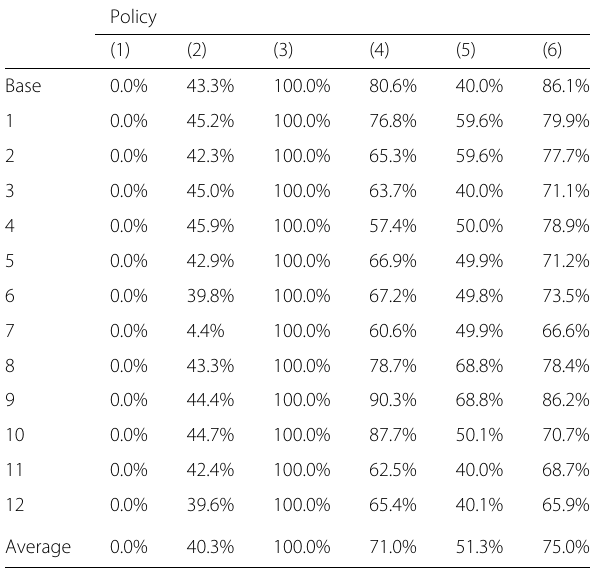
Table 5 The share of intermodal transport in the different synchromodal